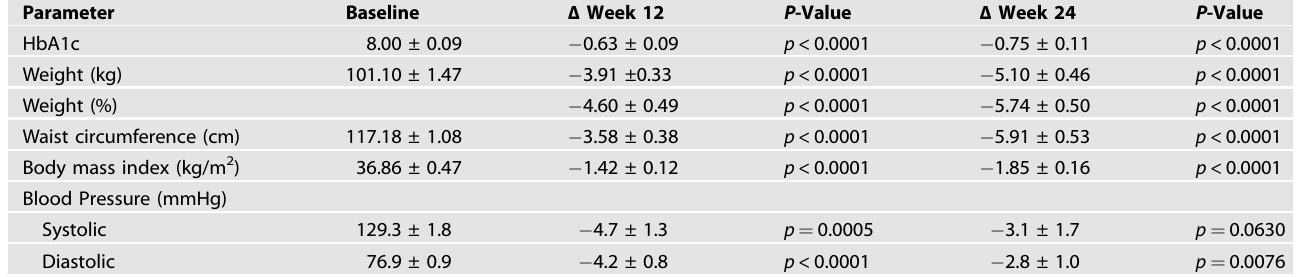
Fig. 1 CONSORT Diagram. Not all persons performed Web Screening. Study was performed from April 2021 till December 2021 in Baton Rouge, Louisiana; Richmond, Virginia; and Gainesville, Florida. Table 1. Change in hemoglobin A1c, body weight, waist circumference, and blood pressure with a 24 week scalable, virtually delivered diabetes- tailored weight management